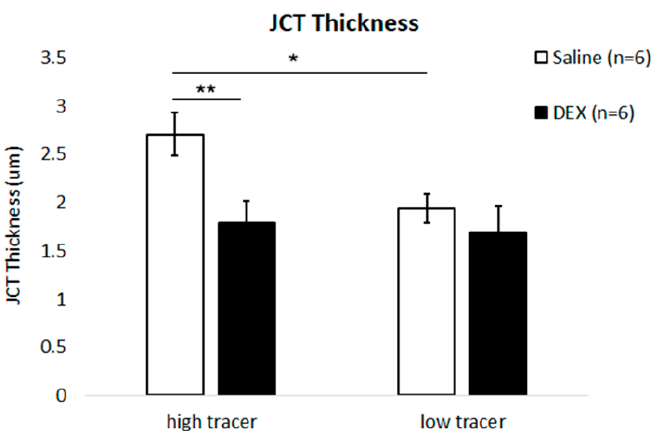
Figure 6. JCT Thickness. A more expanded juxtacanalicular tissue (JCT) was found in high-tracer regions compared to low-tracer regions in control eyes (**: p < 0.01). Dexamethasone (DEX) treatment significantly reduced JCT thickness in high-tracer regions compared to high-tracer regions in control eyes (*: p < 0.05).